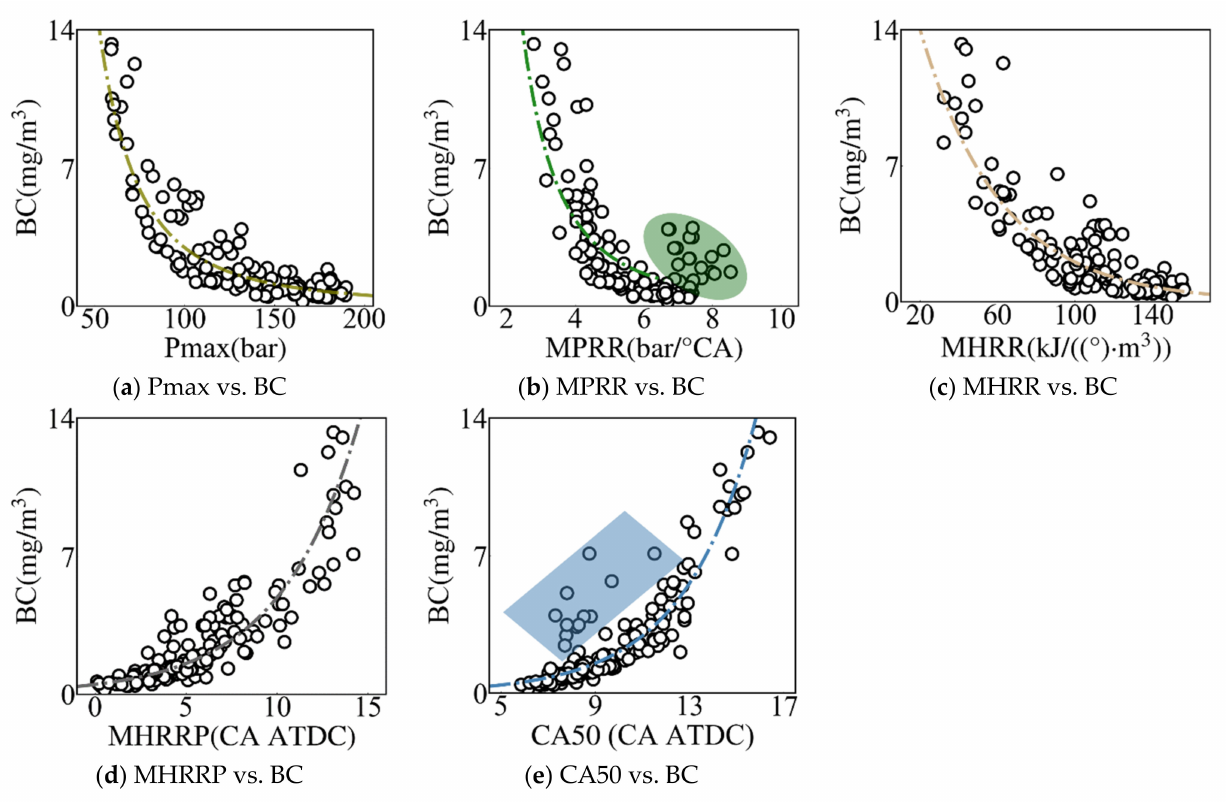
Figure 10. Influence of CCPs changes on BC